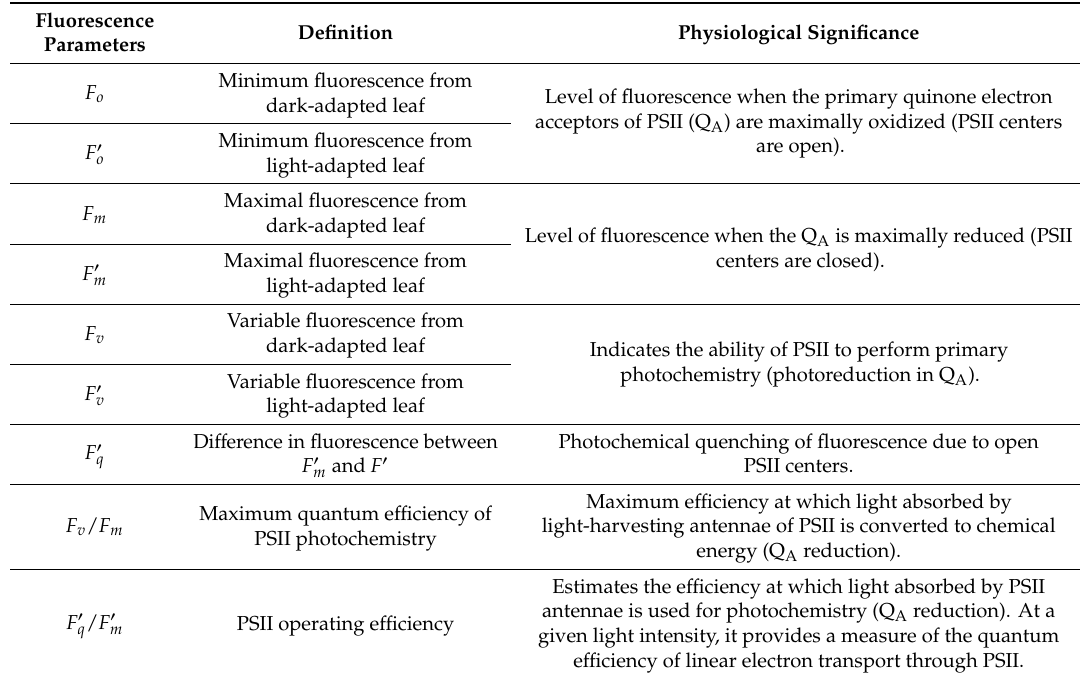
Table 1. Fluorescence parameters of FluorImager